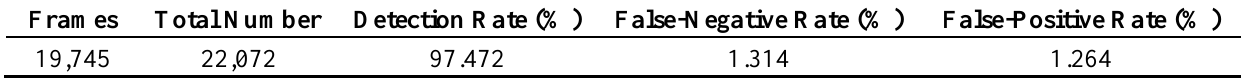
Table 1. Vehicle detection results